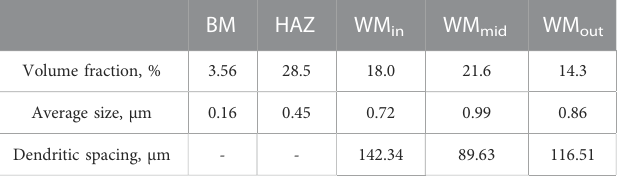
TABLE 2 Average size and volume fraction of the MA constituents in different